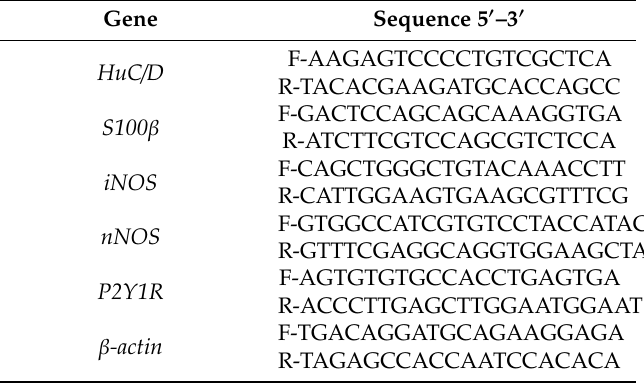
Table 2. Sequence of primers used for q-RT-PCR analysis. Gene Sequence 5 (cid:48) –3